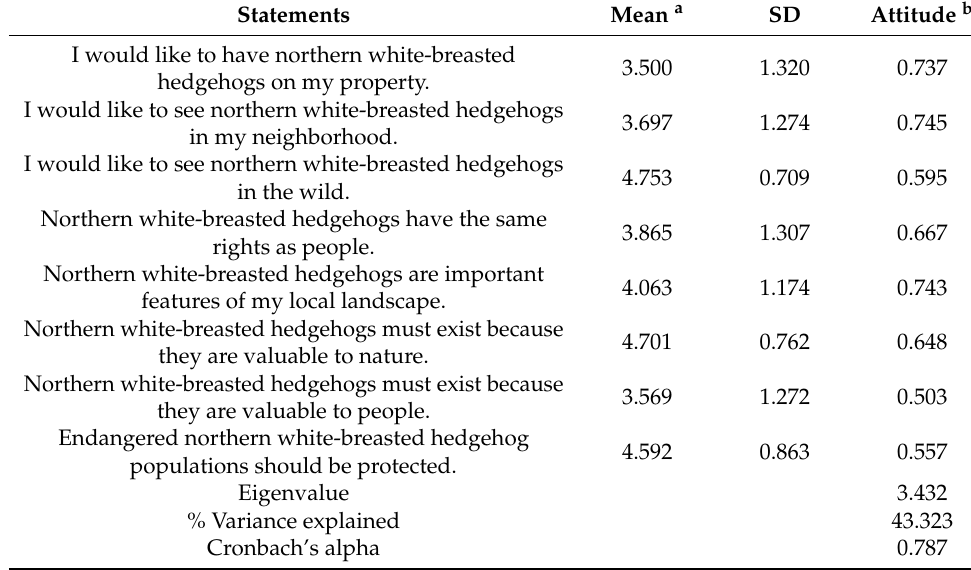
Table 3. Principal components factor analysis of attitudes toward northern white-breasted